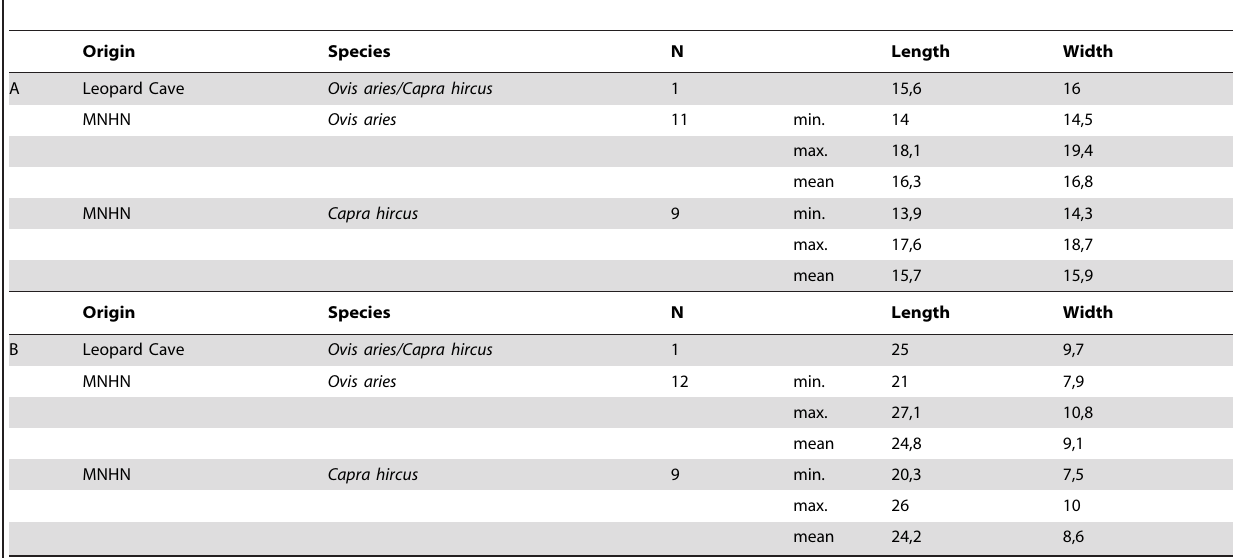
Table 3. Measurements (in mm) of the caprines teeth from Leopard Cave (A: Upper M2; B: Lower M3) compared with modern african specimens from the Muse´um National d’Histoire Naturelle (MNHN).